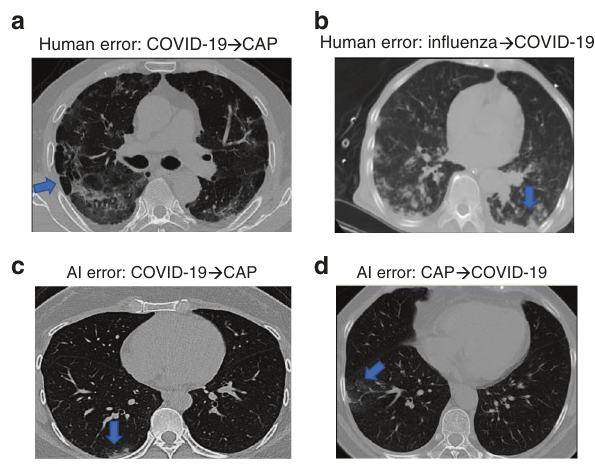
Fig. 4 Examples of incorrect classi fi cations by human readers and the AI system. a CT image of a patient with COVID-19 that all fi ve readers misclassi fi ed as CAP. b CT image of a patient with in fl uenza that all fi ve readers misclassi fi ed it to COVID-19. c CT image of a patient with COVID- 19 that was misdiagnosed as CAP by AI. d CT image of a patient with CAP that AI diagnosed incorrectly as COVID-19. The blue arrows point out some infectious